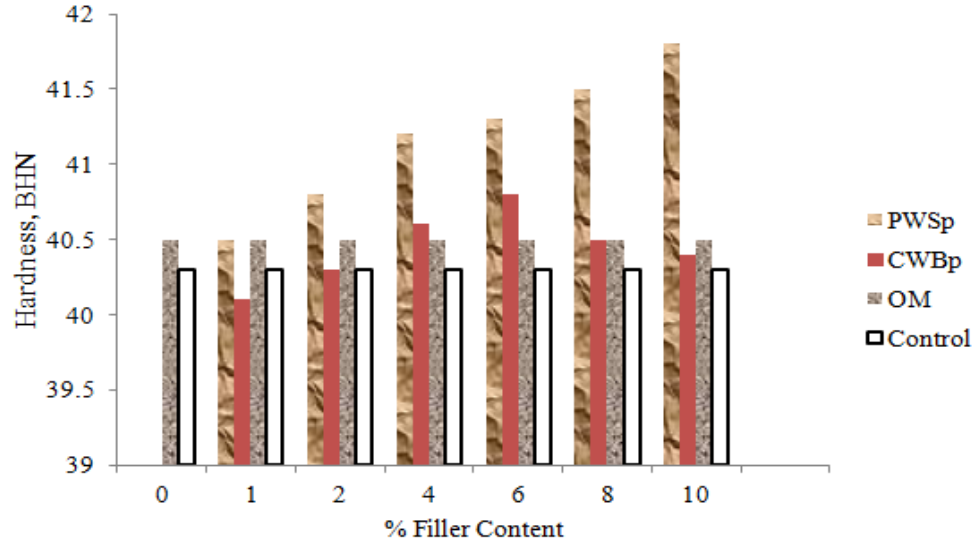
Figure 6: Hardness values for Al/Ps and Al/Cb with Control and